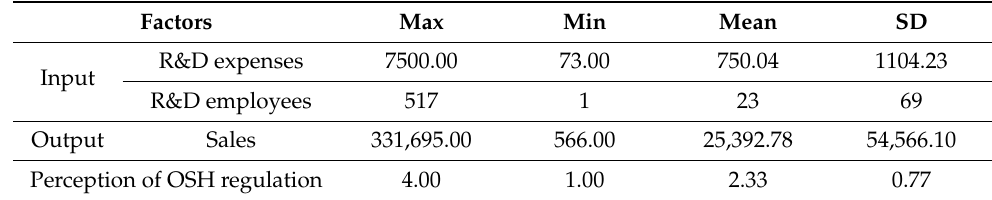
Table 3. Descriptive statistics.